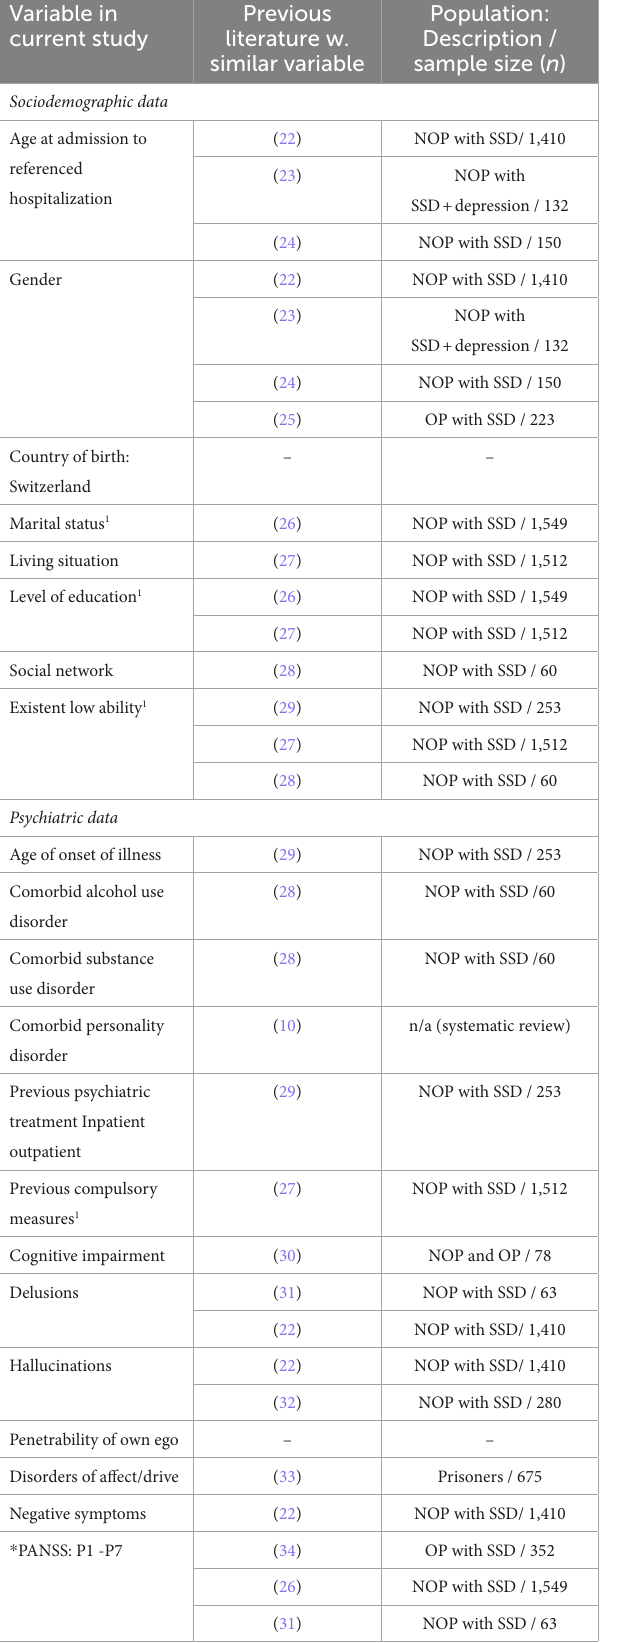
Previous literature